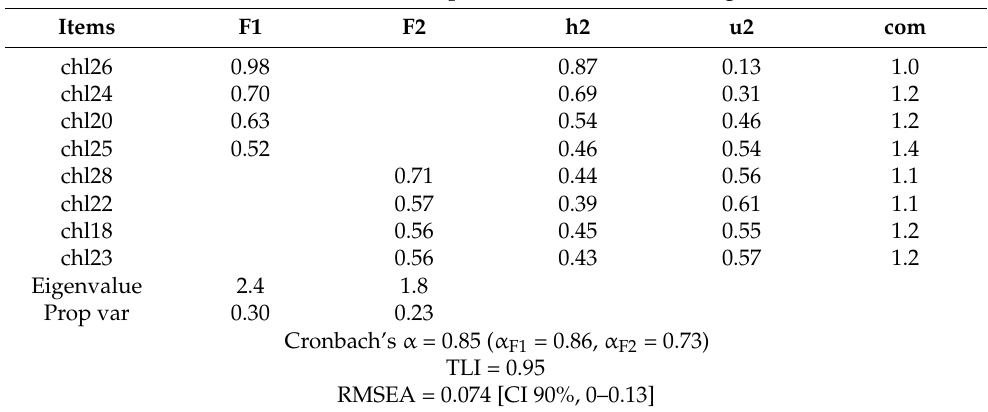
Table 3. Exploratory factor analysis for scale C. Factor loadings < 0.30 are suppressed. h2 = commu- nality (amount of variance explained by common factors). u2 = residual variance (variance unique to the variable). com = indicator of